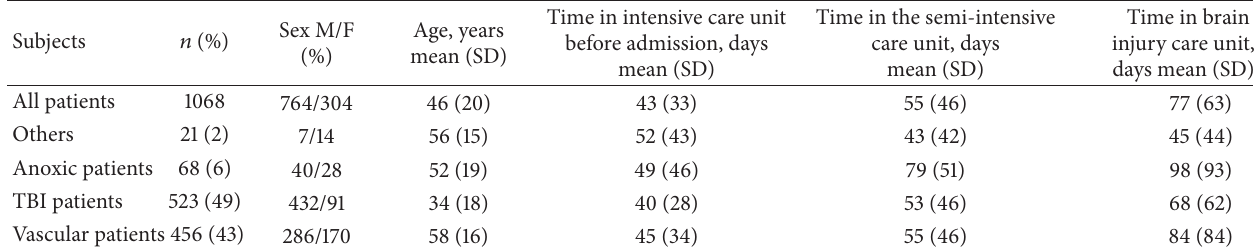
Table 1: Demographic table years: